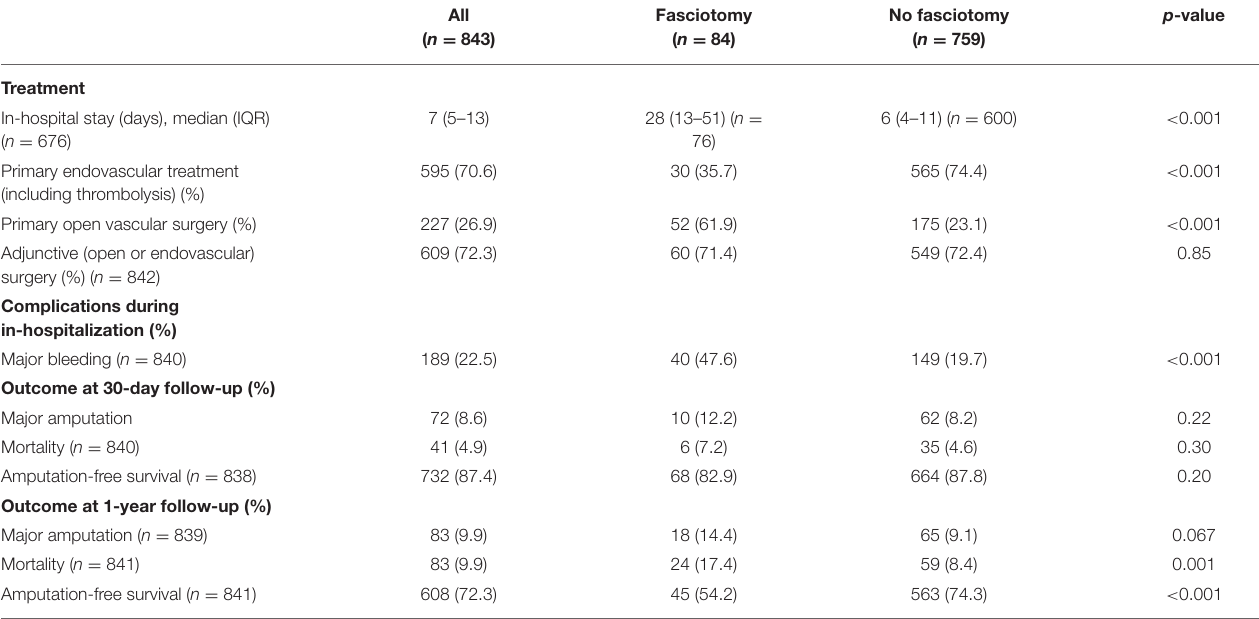
TABLE 3 | Treatment, complications, and short-term outcome in patients undergoing fasciotomy or not after reperfusion for ALI.